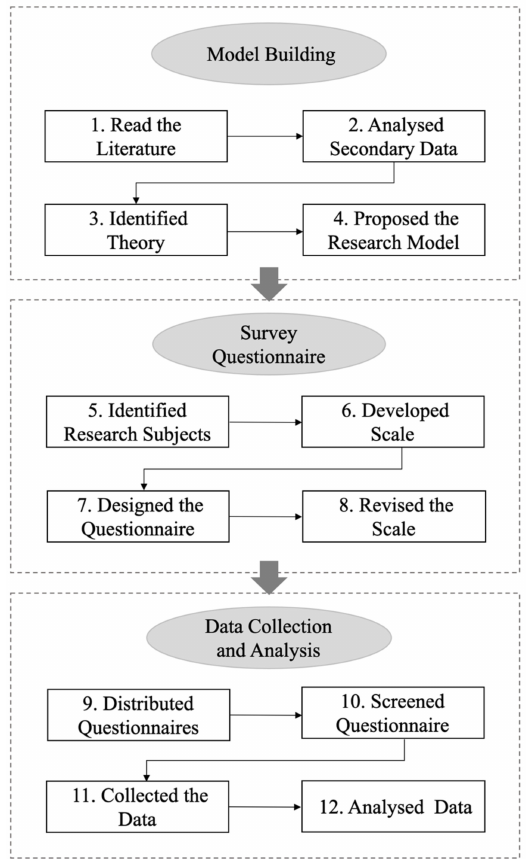
Figure 2. Research